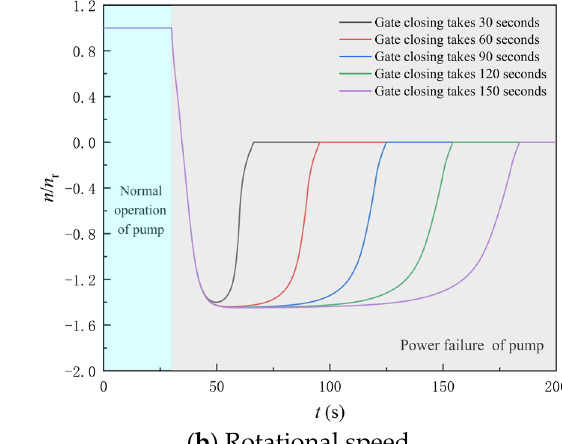
Figure 12. The variation of each KCP with time after a power failure at a 5.35 m net head of the LAPS when the GOOC.